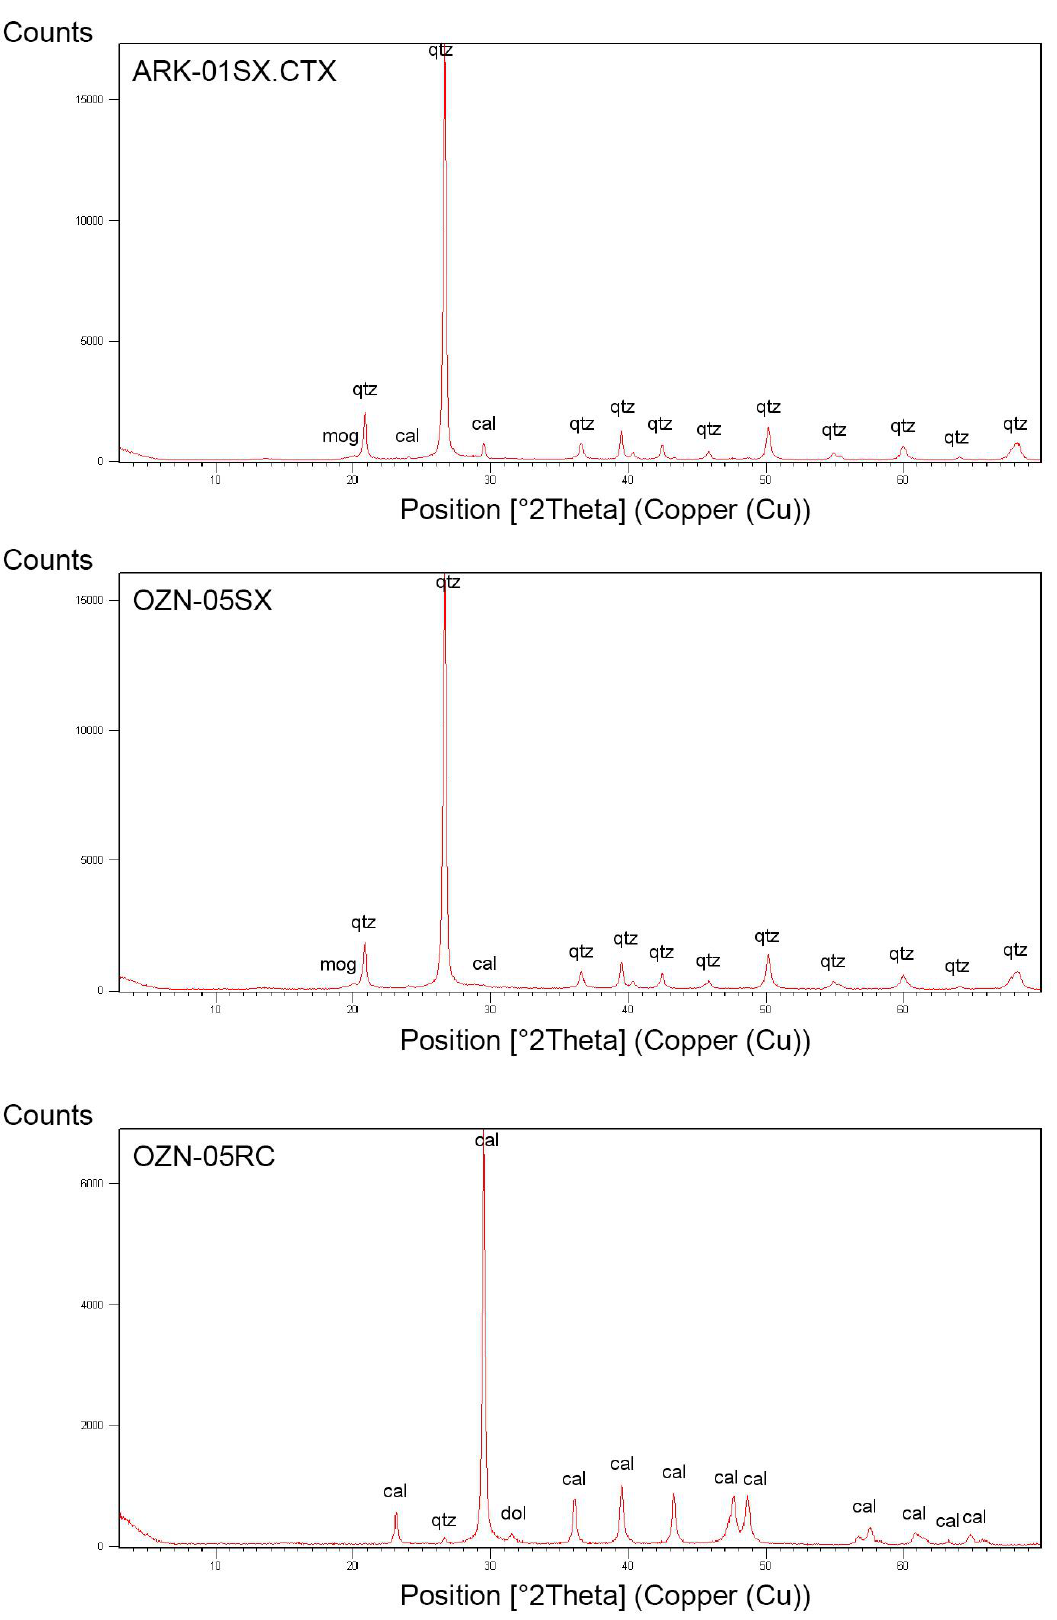
Figure 6. Diffractograms where the mineralogical composition of the nodular flint with cortex is observed (ARK-01SX.CTX). It contains carbonate impurities (calcite - cal) and moganite (mog) traces; flint without cortex (OZN-05SX) with few impurities and moganite (mog) traces; and, carbonate host rock (OZN-05RC) which is limestone (cal) with a small amount of dolomite